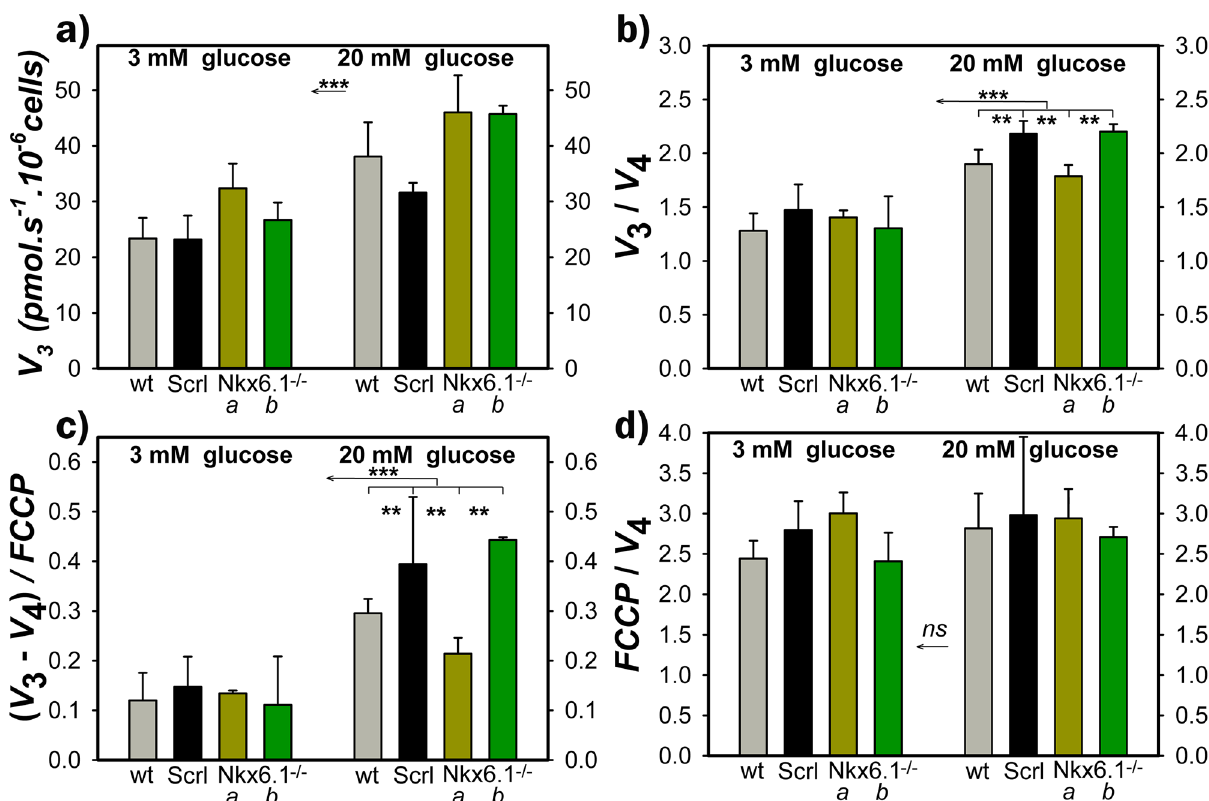
Figure 3. Phosphorylating respiration is not affected by Nkx6.1 ablation—panels show for wt ( gray ), INS- 1E scrl/scrl ( black ), line a ( green ) and b ( dark green ) of INS-1E Nkx6.1 – / – cells at 3 mM and 20 mM glucose: ( a ) Rates of phosphorylating (endogenous) respiration ( V 3 ); ( b ) parameters R r = V 3 / V 4 , i.e. ratios of V 3 to non- phosphorylating respiration rates ( V 4 ), which reflect OXPHOS intensity; ( c ) parameters A r = ( V 3 – V 4 ) / FCCP , where the FCCP is the uncoupled rate in the presence of uncoupler FCCP (titrated to optimum concentration yielding a maximum rate); ( d ) Ratios of FCCP / V 4 . Number of cell passages N was 3–6 on which n of 5–13 respiration assays were performed. ANOVA: *** p < 0.001; ** p < Retained function of ATP‑sensitive K + channel in Nkx6.1‑ablated INS‑1E cells. INS-1E Nkx6.1 – / – cells, preincubated for 1-h in KRH with 3 mM glucose, exhibited a similar rate of the Tl + influx (Tl + as a sur-